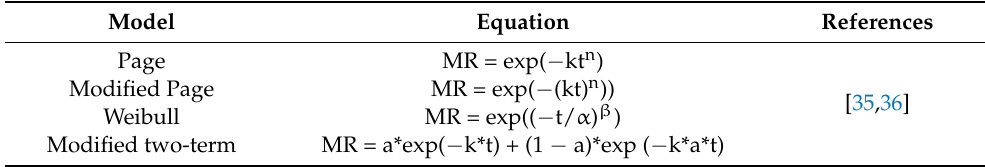
Table 1. Mathematical models for convection